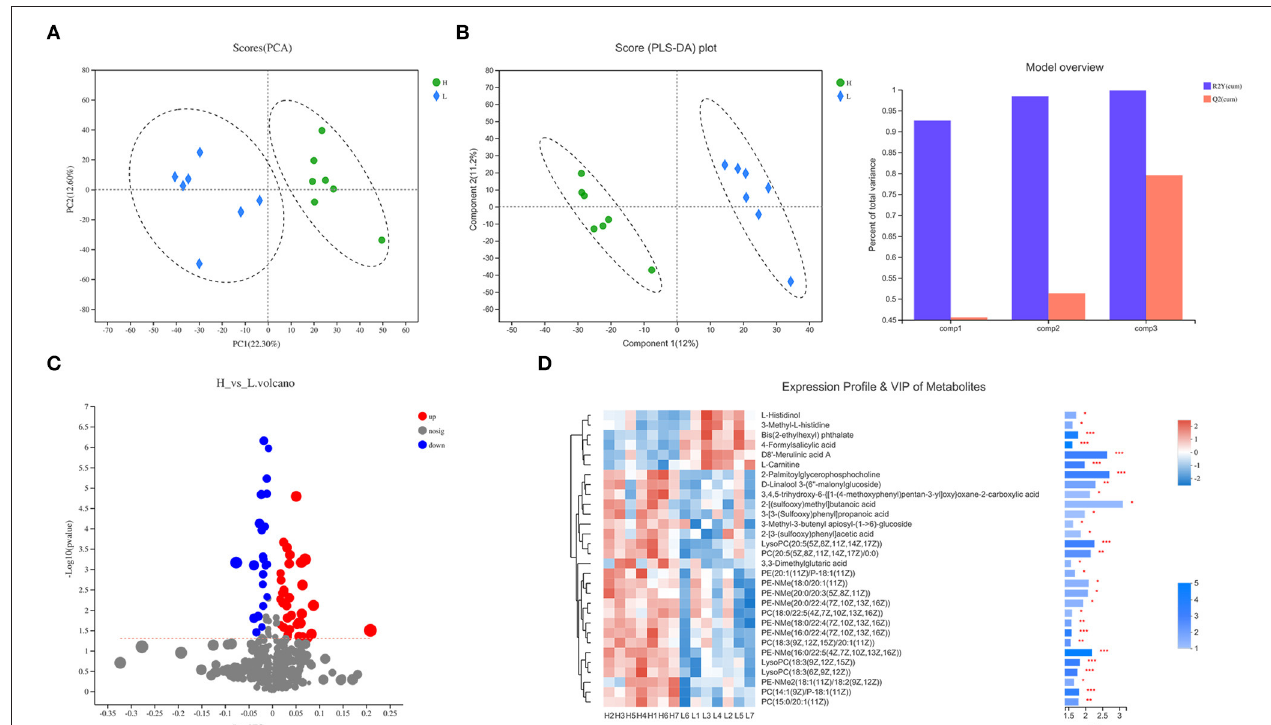
FIGURE 1 | Serum metabolite profile of lambs with different average daily gain (ADG). (A) PCA score plot for serum metabolites of high ADG lambs (H) and low ADG lambs (L). (B) PLS-DA score plot for serum metabolites of high ADG lambs (H) and low ADG lambs (L), and model overview showing high R2Y and Q2. (C) Enhanced Volcano plots of OPLS-DA showing fold changes (log 2 FC) and the negative logarithm (base 10) of the P -values of 57 differential serum metabolites in high ADG lambs compared with low ADG lambs. (D) Expression profile, VIP score, and P- value of the top 30 differential serum metabolites in high ADG lambs compared with low ADG